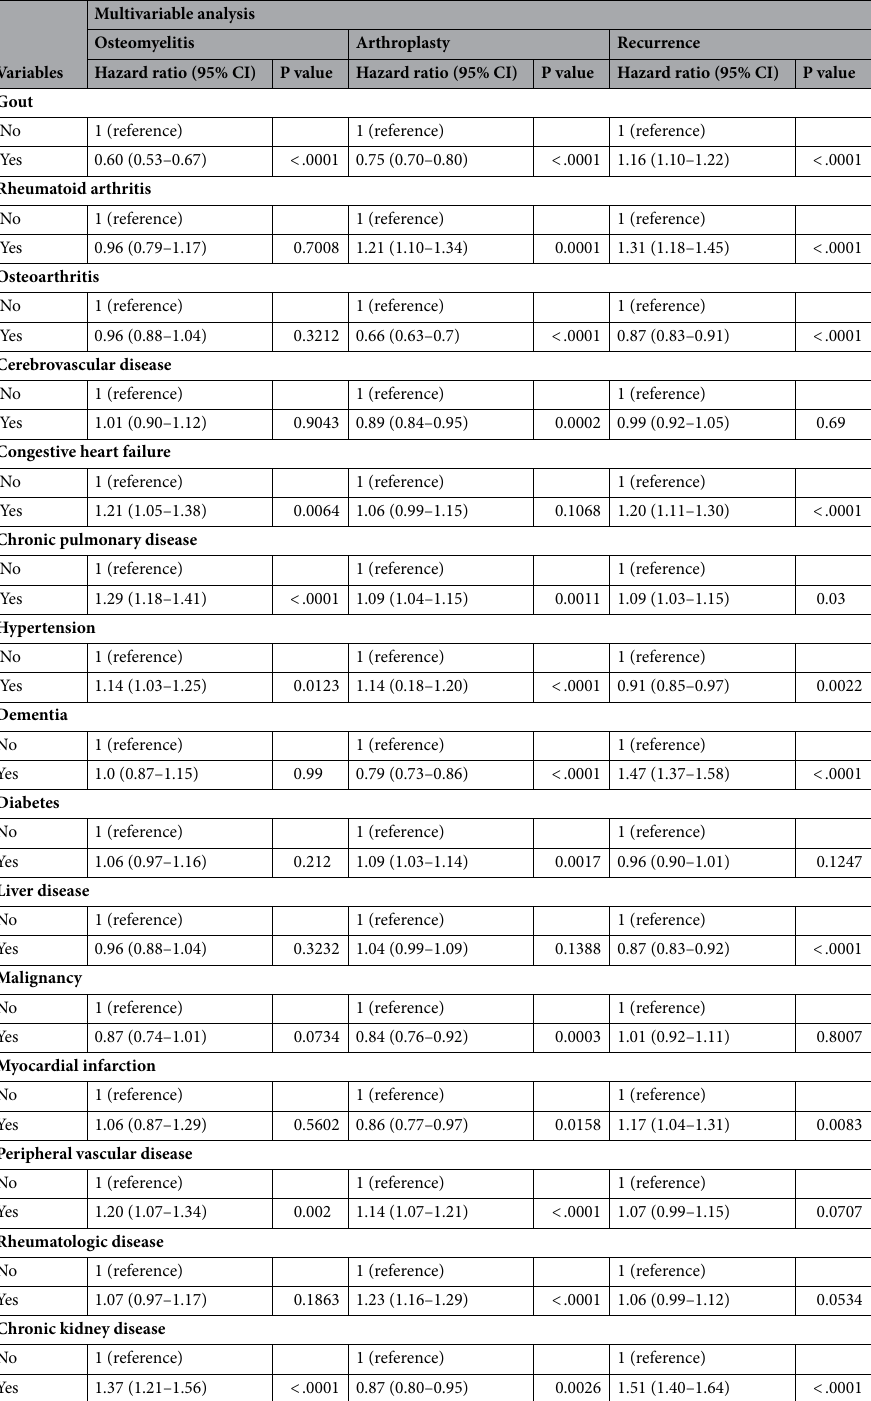
Table 7. Cox proportional hazard models of secondary